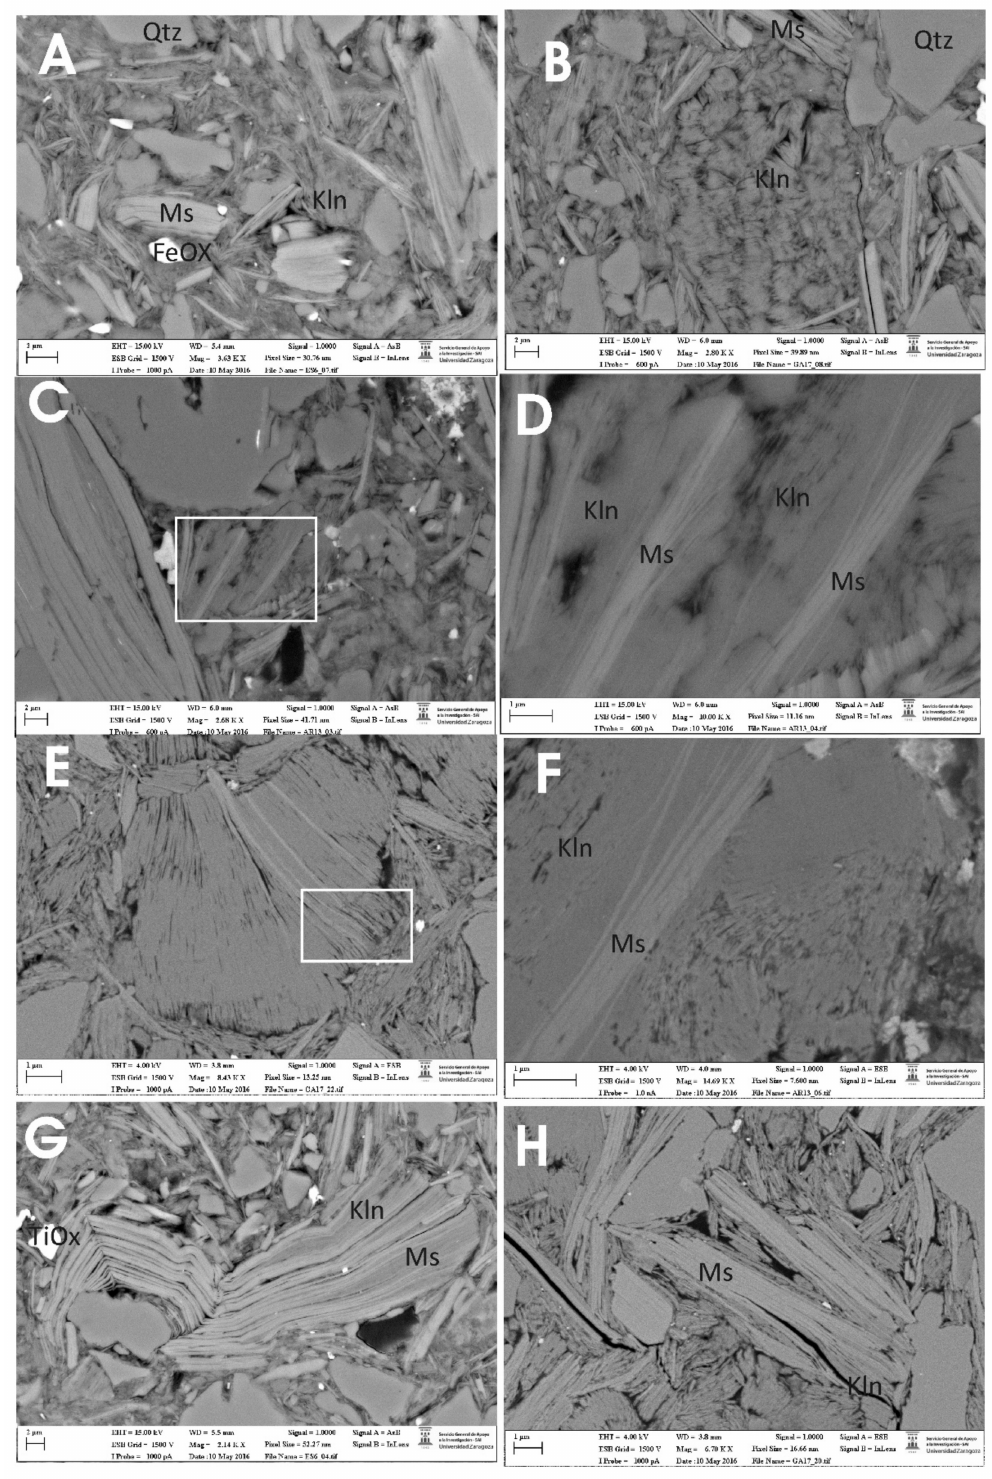
Figure 5. BSE/FESEM images of polished sections. ( A , B ) show the typical texture of the rocks with random orientations. ( C – H ) show the presence of mica-kaolinite intergrowths. ( D ) is an enlargement of ( C ). Qtz: Quartz, KF: K feldspar, M: Mica, Kln: kaolinite, FeOx: Fe oxides, TiOx: Ti oxides. All these textures suggest an in-situ origin for kaolinites in contrast with the detrital origin of the K